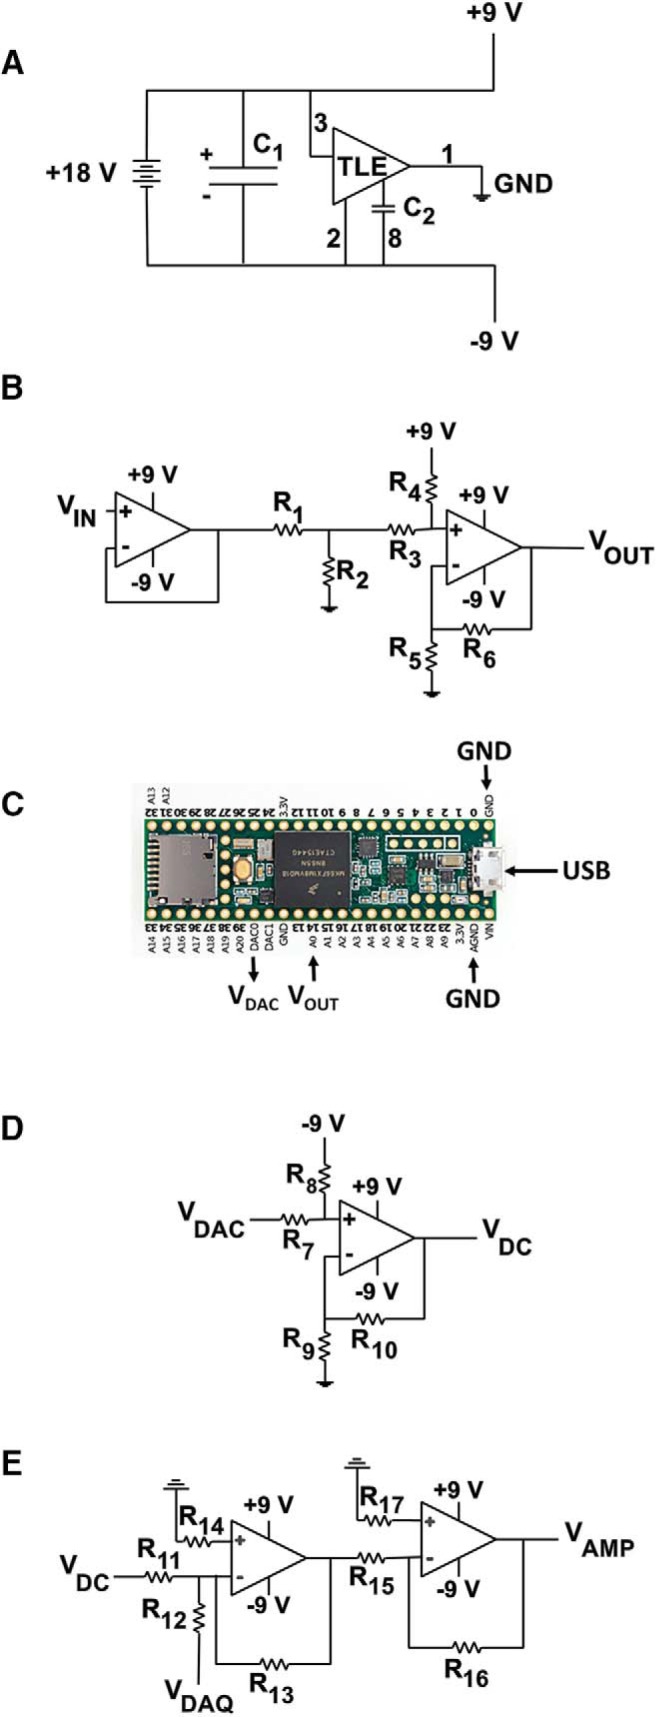
Breadboard electronics. The five parts of the system illustrated in Fig. 1B are shown schematically. A, Rail splitter power supply. An 18-V power supply (wall adaptor) is split by a TLE 2426 rail splitter IC into 9 V, –9 V, and ground. The capactors are C1 = 200 μF and C2 = 1 μF. The dark numbers refer to the pins of the TLE 2426 IC. B, Follower, voltage divider, and differential amplifier circuits to map the range −9 to 9 V onto the range 0 to 3.3 V. The resistor values are R1 = 2200 Ω, R2 = 470 Ω, R3 = 4700 Ω, R4 = 22,000 Ω, R5 = 10,000 Ω, and R6 = 100 Ω. C, Connections to the Teensy 3.6 microcontroller. The output of the previous circuit is fed to pin A0, and the output of pin DAC0 is fed to the next circuit. D, Differential amplifier circuit to transform the output of the microcontroller (0–3.3 V, representing the dynamic clamp current) into a range (±9 V) expected by the intracellular amplifier. The resistor values are R7 = 4700 Ω, R8 = 22,000 Ω, R9 = 10,000 Ω, and R10 = 10,000 Ω. E, Summing amplifier. The voltage command from the DAQ board (representing the current clamp’s specified current) is added to the voltage command from the Teensy microcontroller. The sum is sent to the command input of the intracellular amplifier. Resistors R11, R12, R13, R15, and R16 are 10,000 Ω; resistor R14 is 3300 Ω; and R17 is 4700 Ω.